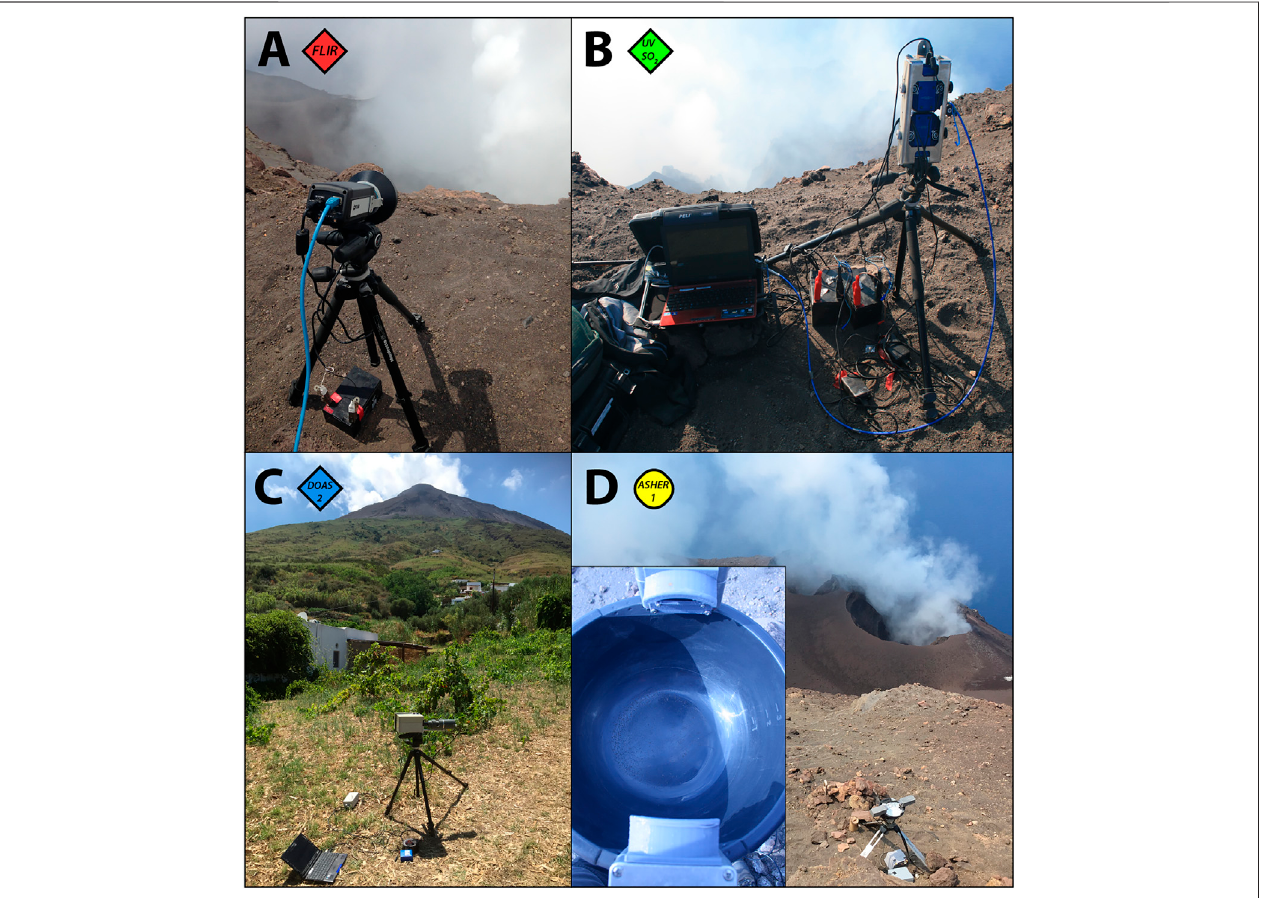
FIGURE 3 | (A) FLIR camera aiming pyroclasts from the South West (SW) crater. (B) Ultra-Violet (UV) SO 2 camera aiming volcanic plumes from the SW crater. (C) ASH collector and sizER (ASHER) instrument measuring and collecting ash fallouts. In the background, panorama of the Central (on the left) and the North East (on the right) active craters of Stromboli volcano in July 2016. (D) Differential Optical Absorption Spectroscopy (DOAS) instrument with the summit area of Stromboli in the background.